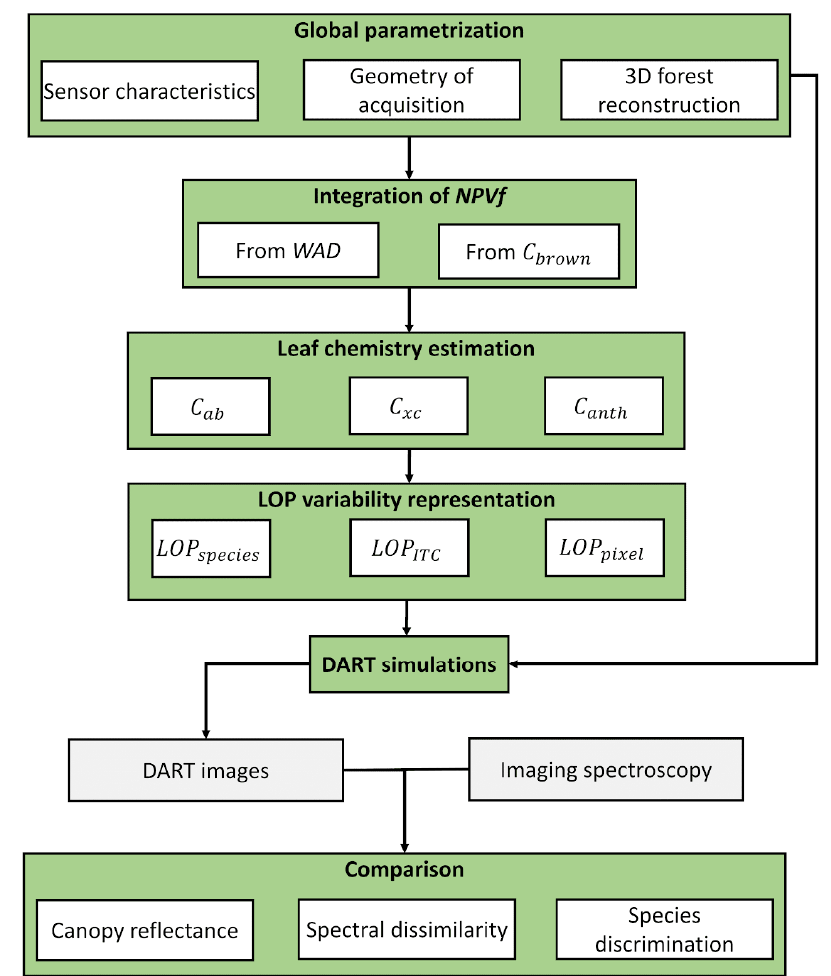
Figure 2. Flowchart of the approach proposed to test the influence of different scenarios for the integration of non-photosynthetic vegetation fraction ( NPVf ) and heterogeneity in leaf optical properties ( LOP ) when simulating imaging spectroscopy of complex canopies.